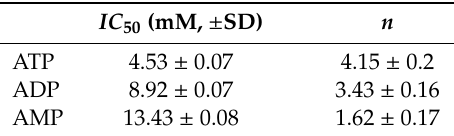
Table 1. Fit values of IC 50 and n for ATP, ADP, and AMP inhibition e ff ects on lysenin channel conductance.